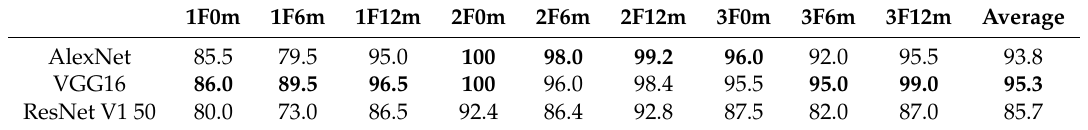
Table 3. Position classification accuracy (%) with the three CNNs.